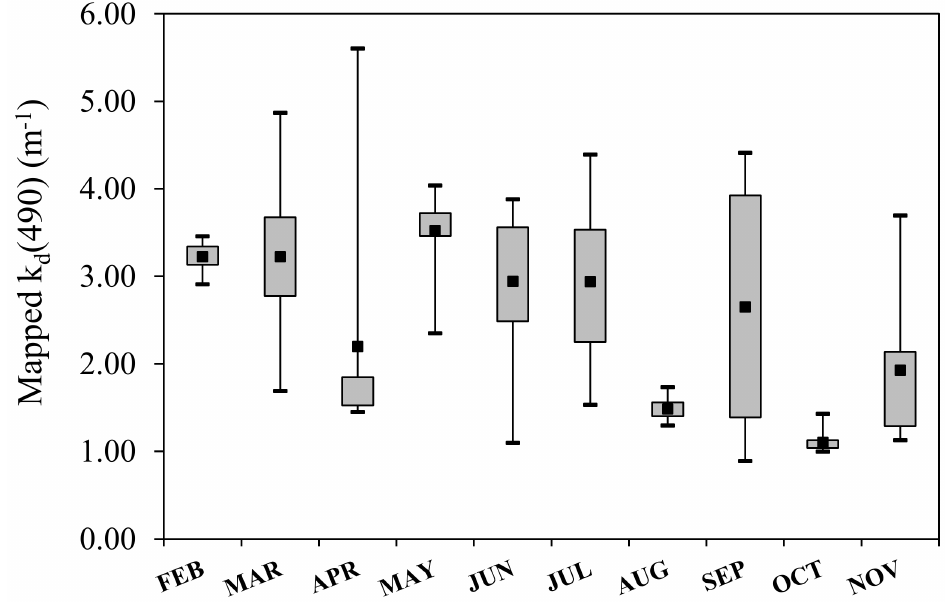
Figure 8. Boxplot of the k d (490) spatial distribution regarding the months of February to November of 2016 in the Bariri